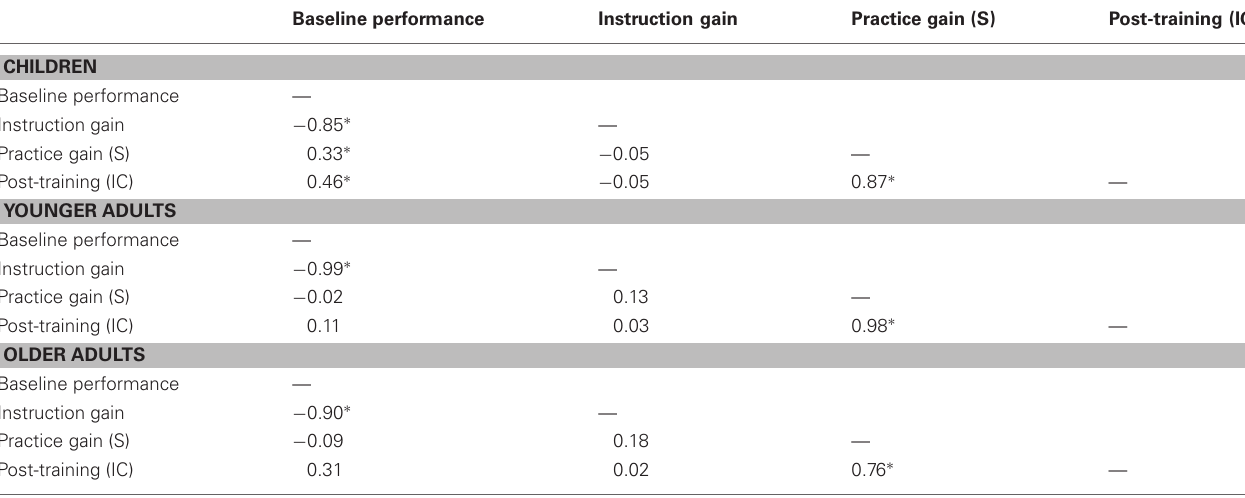
Table 5 | Correlations among baseline memory performance, instruction gain, gain from practicing (S), and post-training performance (IC) separately for the age